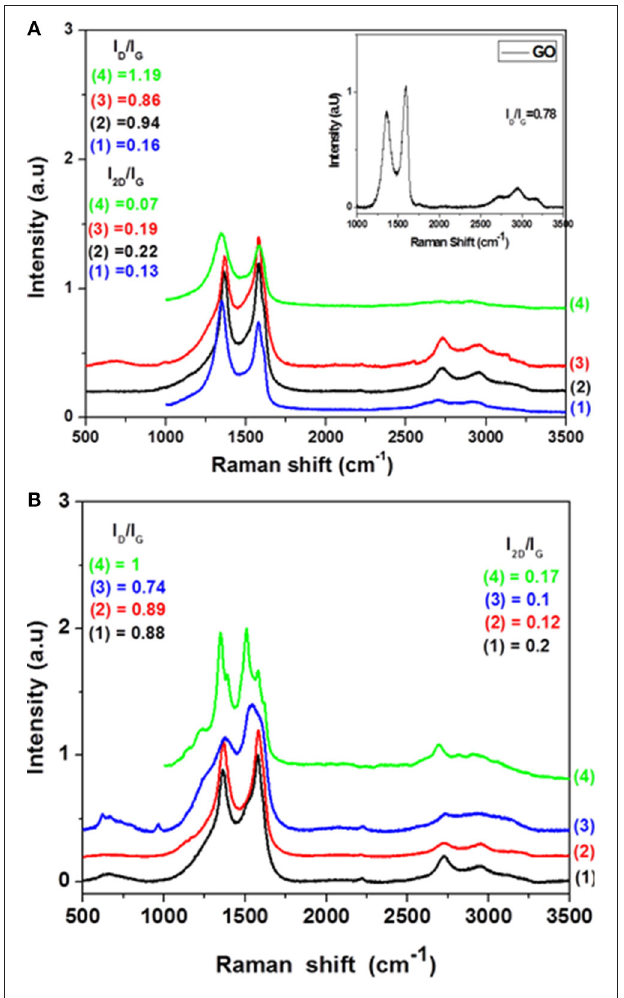
FIGURE 7 | Raman spectra of aerogels with (A) aliphatic diamines (1:rGO EDA , 2:rGO HDA , 3:rGO TETA , 4:rGO PXDA ), (B) aromatic diamines (1:rGO PPD , 2:rGO MDA , 3:rGO DAB , 4:rGO OPD ).